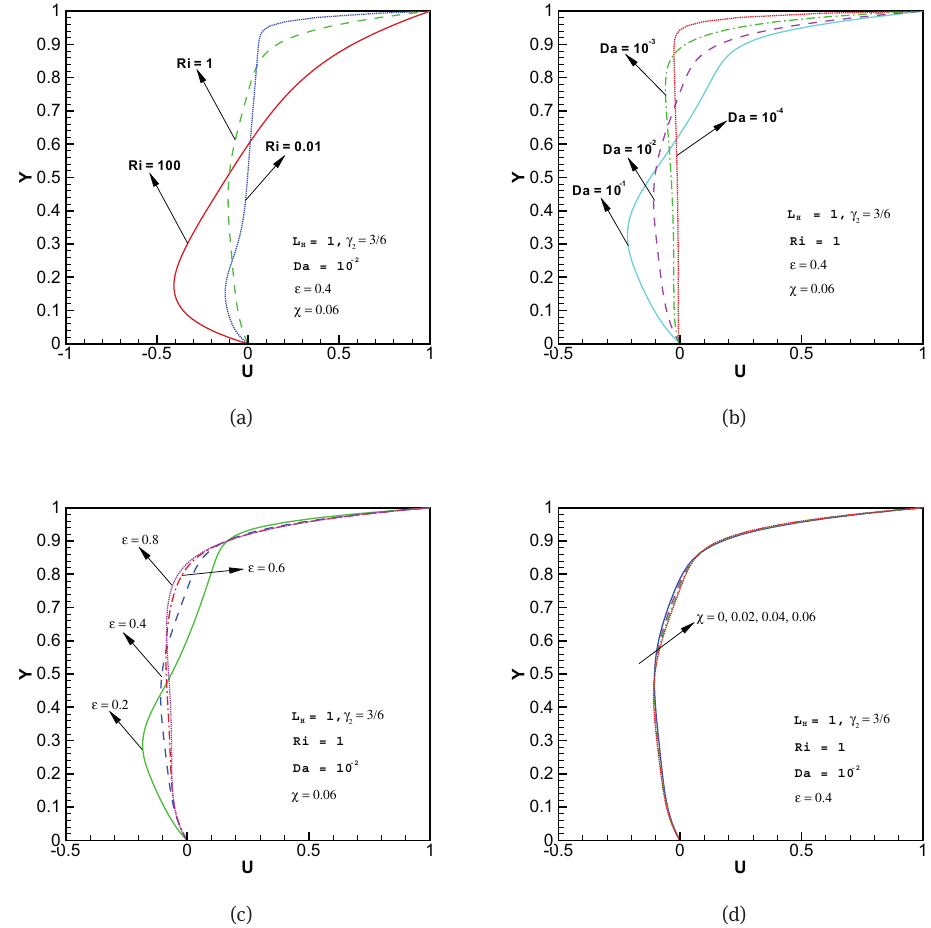
Fig. 8: U- velocity profiles at mid-plane of the cavity for different (a) Ri , (b) Da , (c) ϵ , and (d) χ .